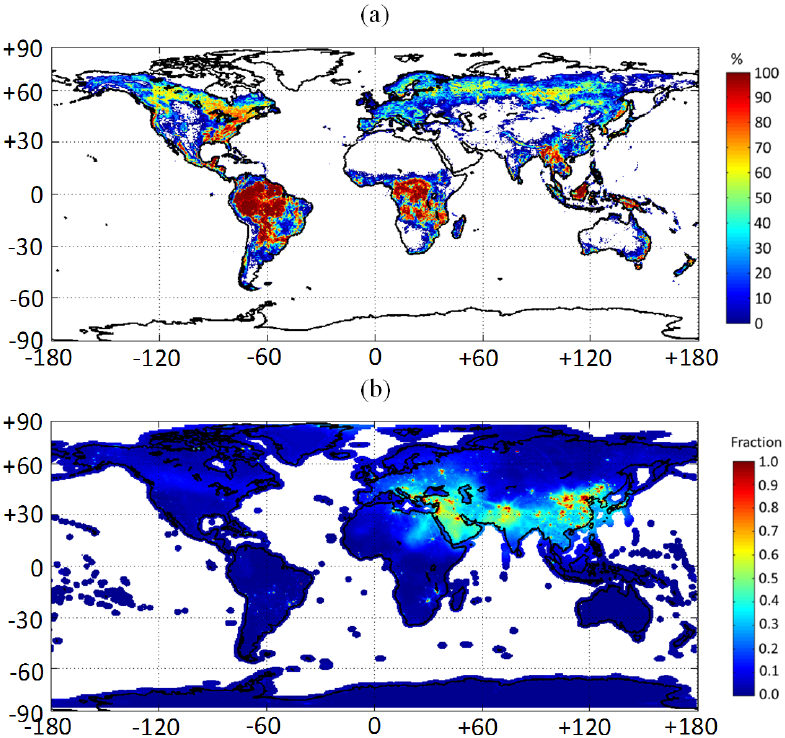
Figure 7. Global map of the mean forest-cover percentage used in the SMOS L2 SO and L3 MO soil moisture retrievals (a) and map of the radio frequency interference (RFI) probabilities (b) for ascending orbit from the L3MO soil moisture processor.